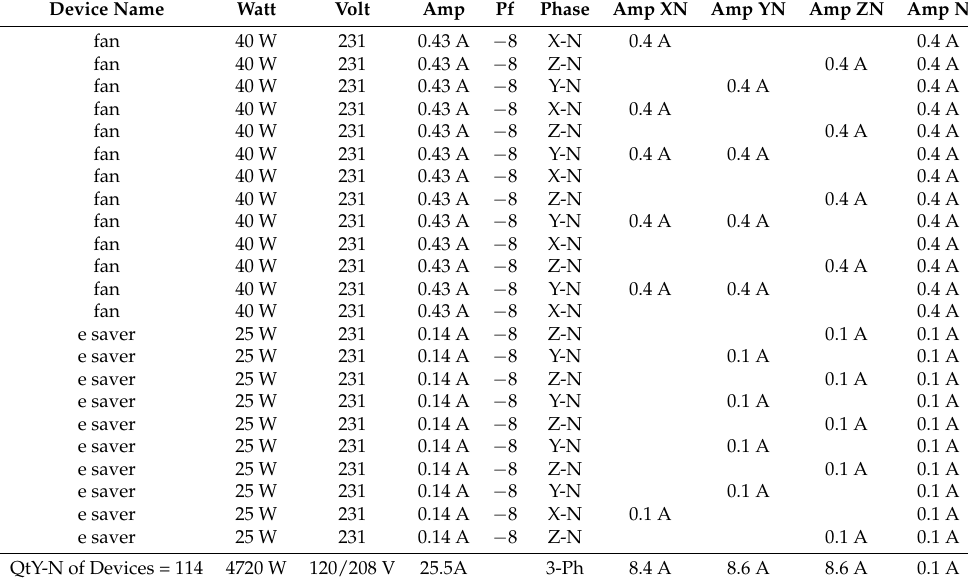
Table 11. Rahman Baba Hostel proposed load data.